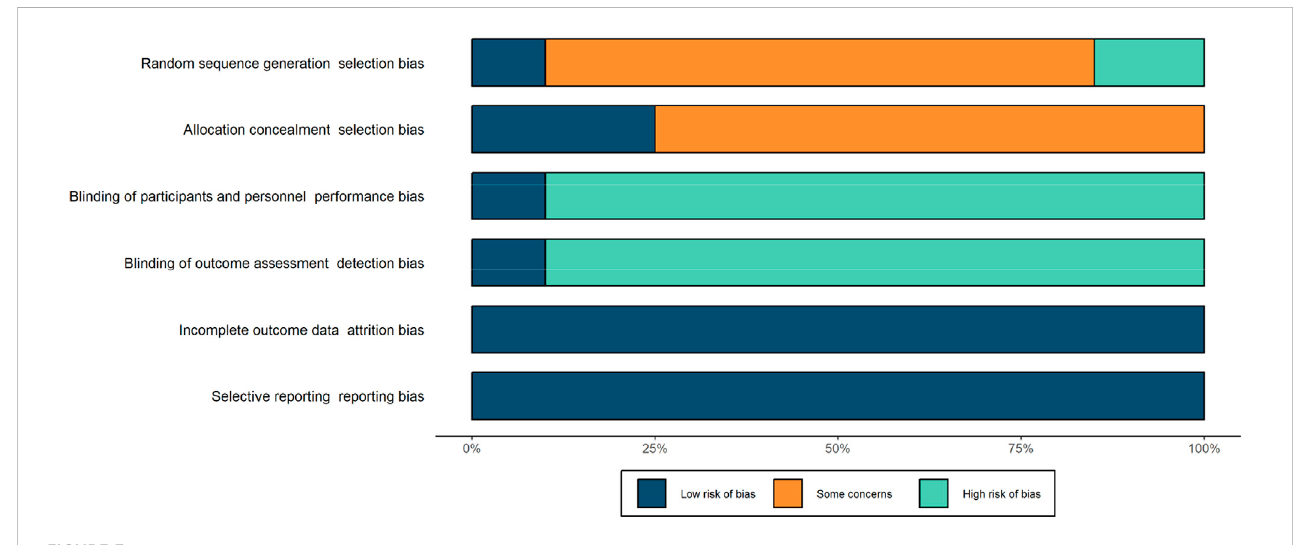
FIGURE 3 Risk of bias summary for all included